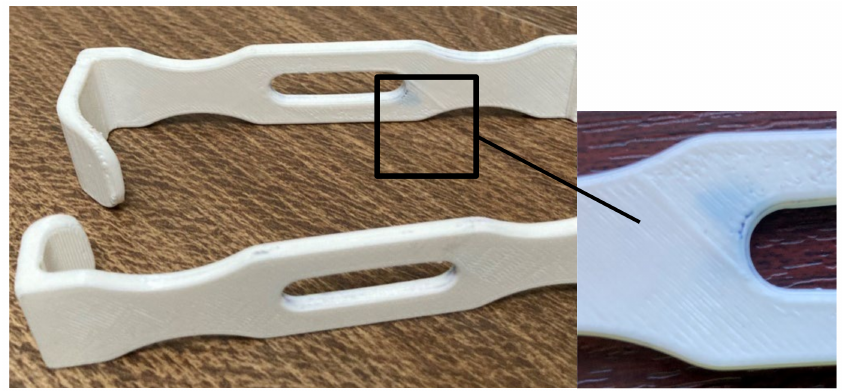
Figure 11. Retractors treated with acetone and